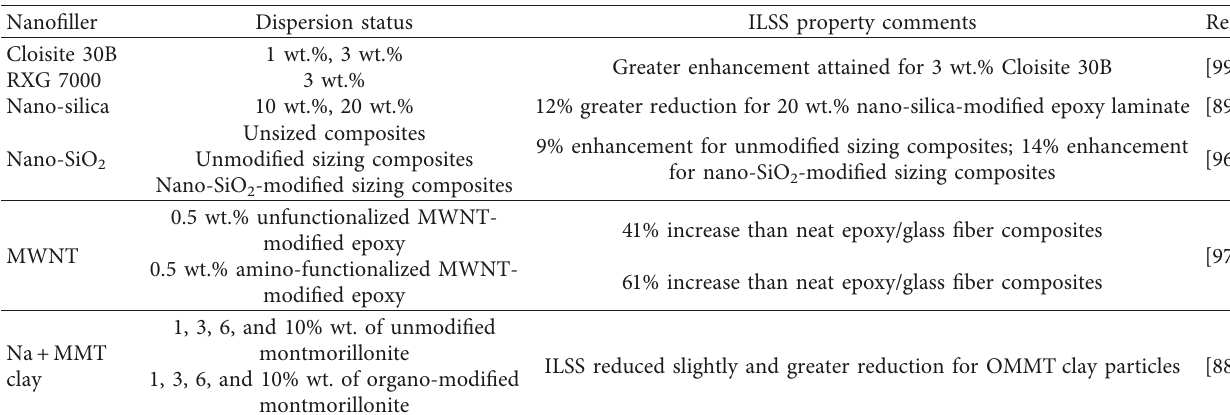
Table 4: ILSS property for various nanofillers.